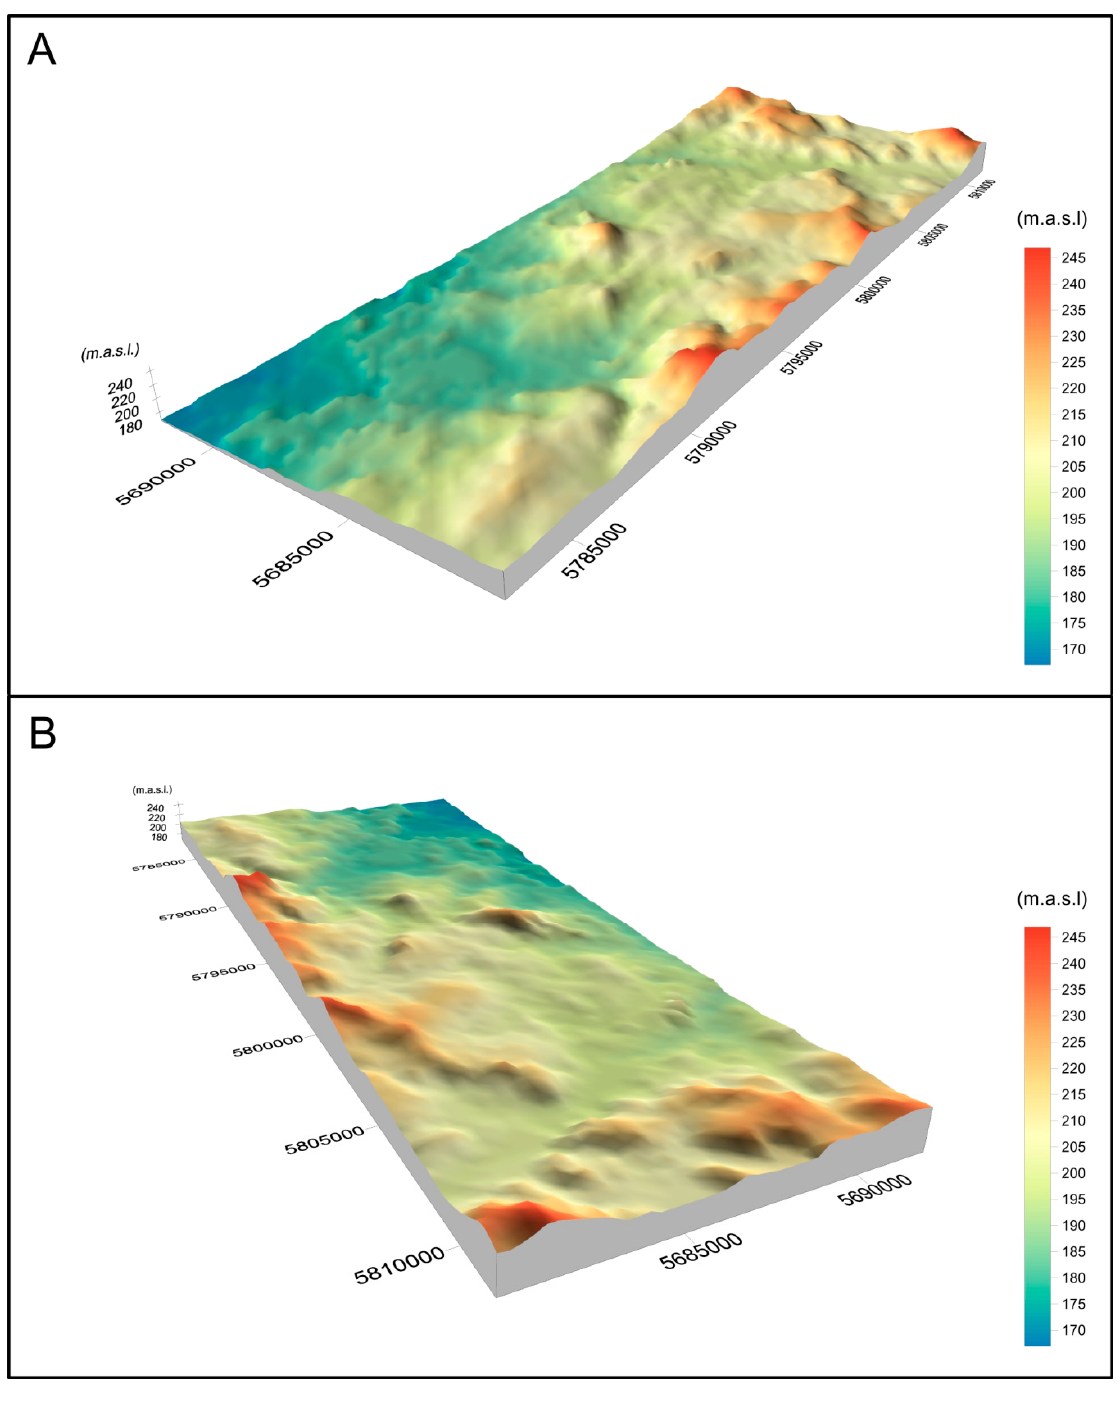
Figure 3. Digital Elevation Model of the analyzed area from the pre-investment period. Three-dimensional view using a standard color ramp with shading, z-factor parameter value of 13—SW view ( A ) and SE view ( B ). Source: Own elaboration.